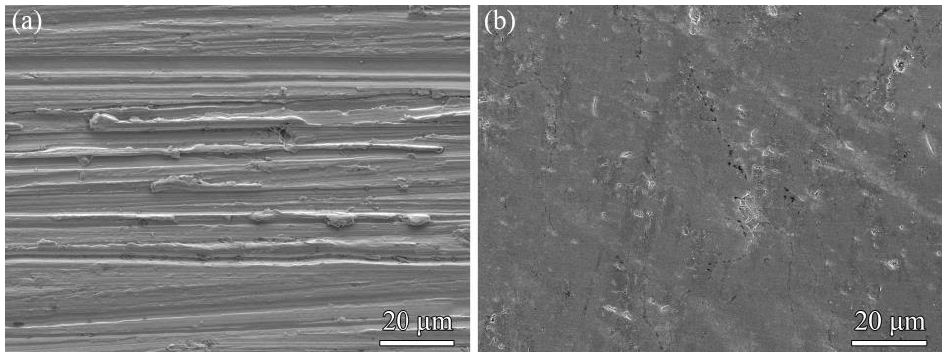
Figure 5. Surface morphologies of the ( a ) CG and ( b ) GNS samples after polarization.